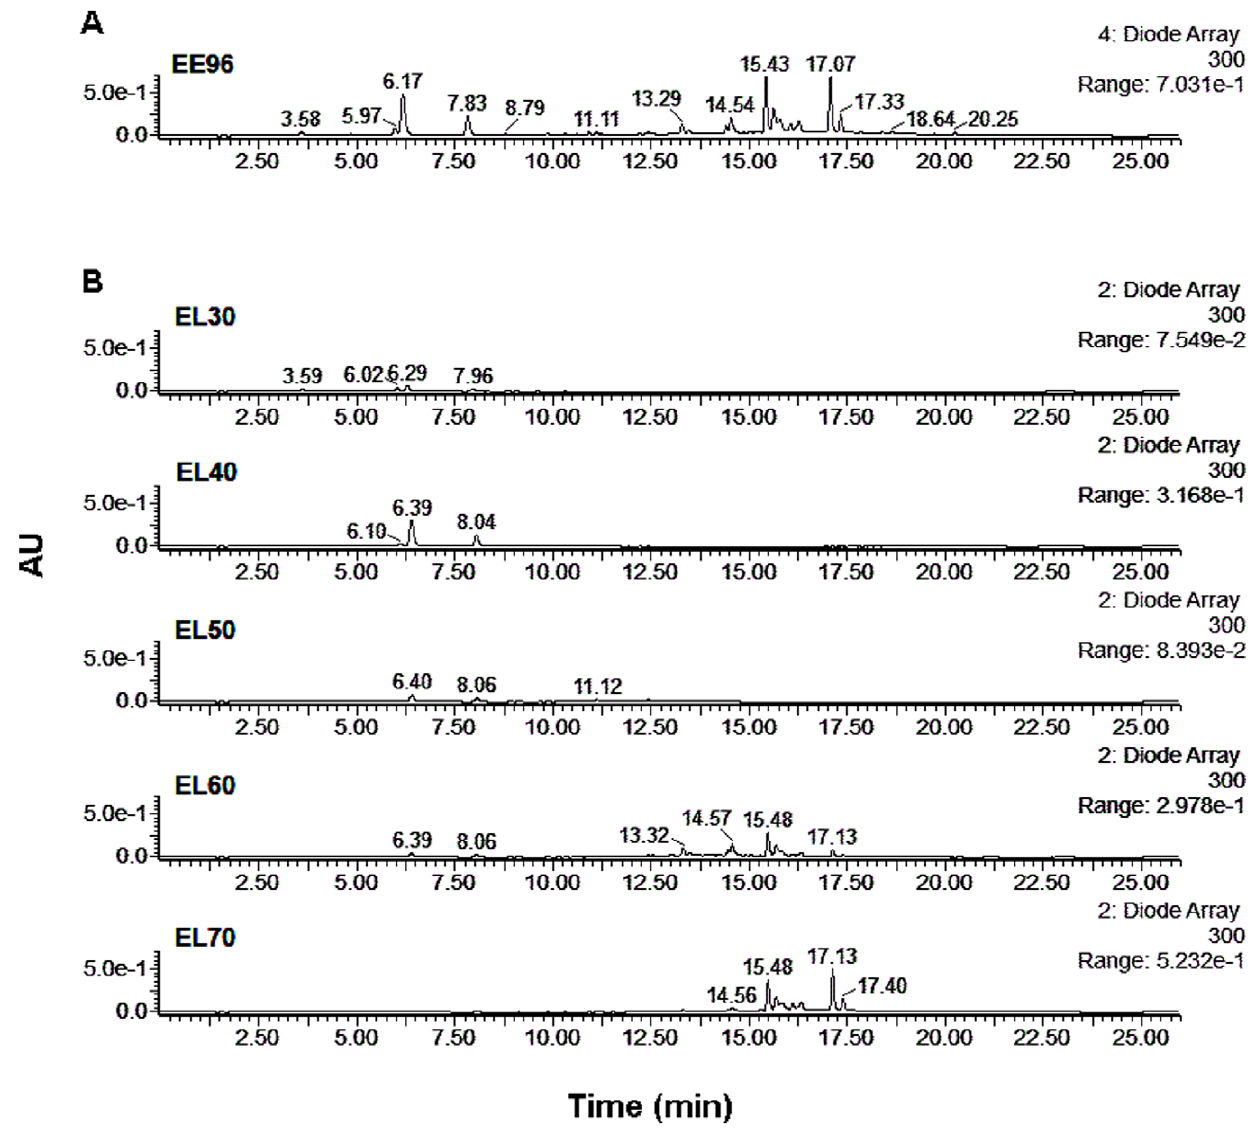
Figure 2. LC-DAD (300 nm) chromatogram of the phenolic compounds following solid-phase extraction without fractionation (A: EE96) and with fractionation (B: EL30–EL70). AU, arbitrary units.